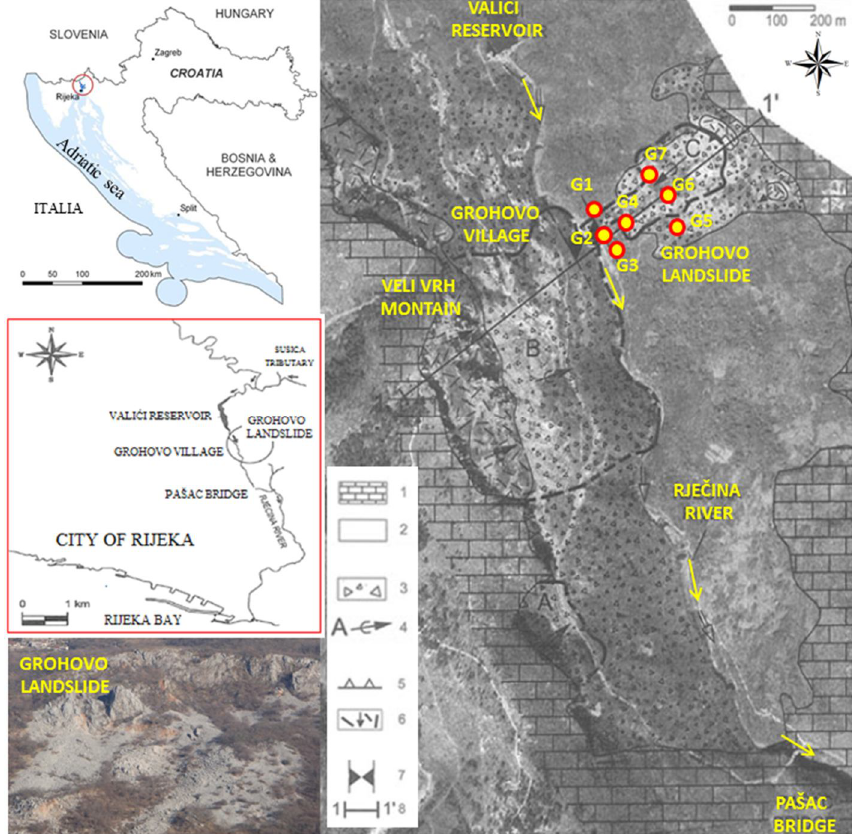
Figure 2. Simplified engineering geological map of the Rjeˇcina River valley: 1 – carbonate bedrock (Cretaceous and Paleogene limestones); 2 – flysch deposits (Paleogene silty marl, shale and sandstone) covered by primarily fine-grained slope deposits; 3 – flysch deposits covered by rockfall talus; 4 – mass movements in the 20th century: A is 1979, B is 1908 and C is 1996; 5 – scarps; 6 – isolated rock blocks on flysch deposits; 7 – area with high risk of damming; 8 – engineering geological cross section (Benac et al., 2009; modified by Elvis